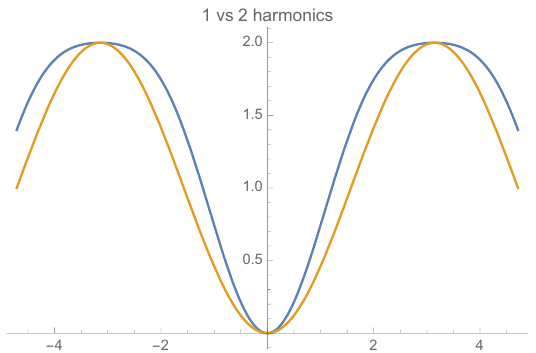
Figure 6 . Single cosine (orange) vs 2 harmonic potential (blue). Here we take an example with: V orange = (1 − cos( θ )) and V blue = (1 − cos( θ )) + 0 . 2(1 − cos(2 θ )) . For the 2 harmonic potential the curvature at the top is a factor 9 smaller than the curvature at the minimum of the